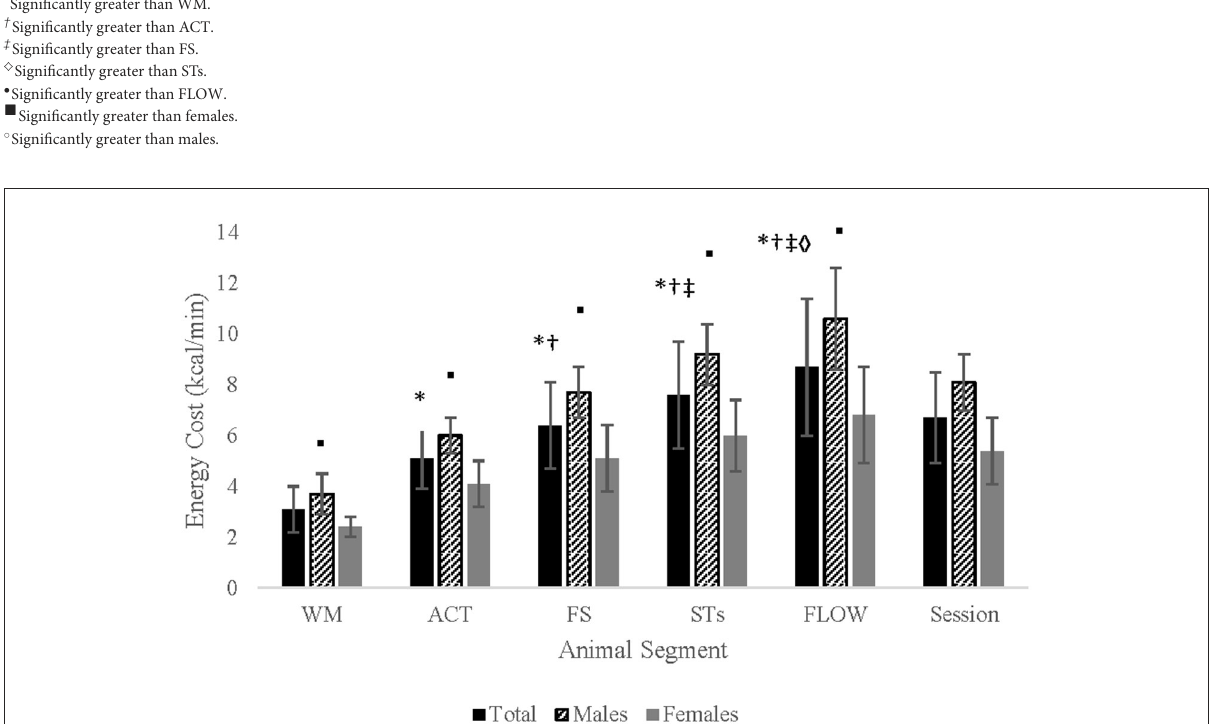
FIGURE3 Kcal/min between genders for each segment of the Animal Flow session. WM, wrist mobilizations; ACT, activations; FS, form stretches; STs, switches and transitions; FLOW, choreographed flow; *significantly greater than WM; † significantly greater than ACT; ‡ significantly greater than FS; ♦ significantly greater than STs; ◦ males significantly greater than